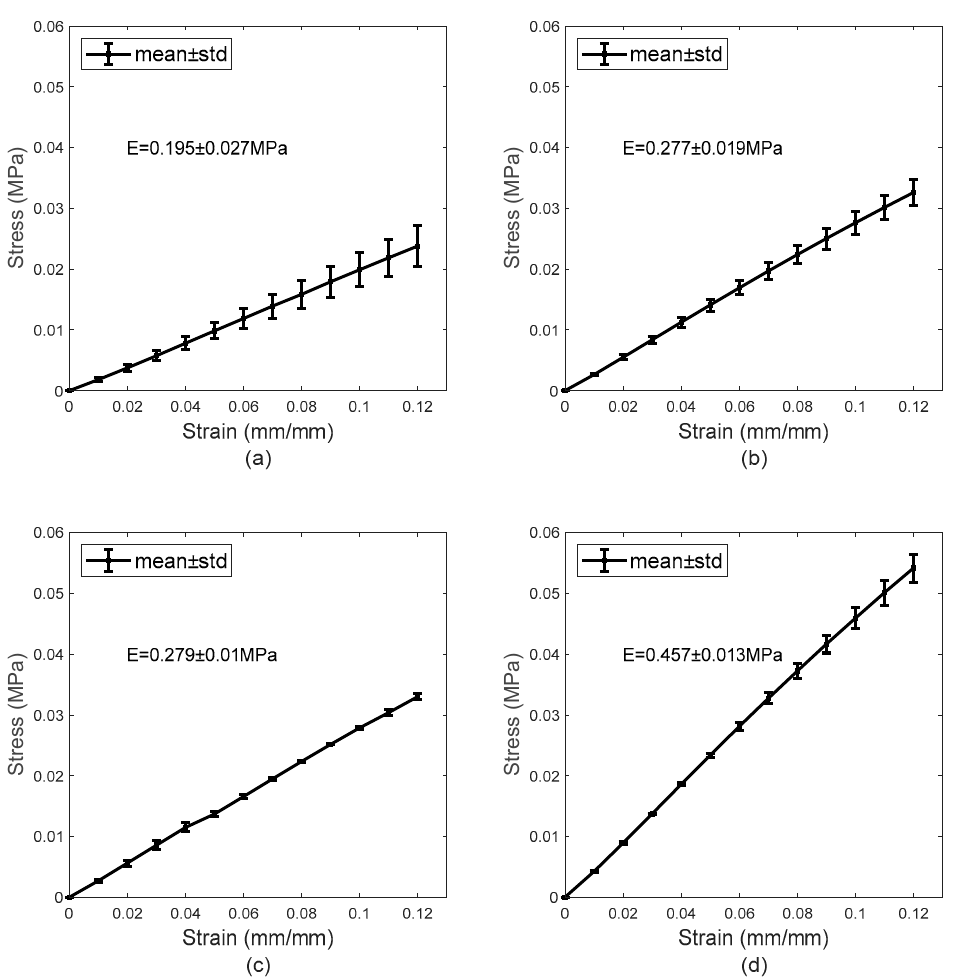
Figure 7. Mean stress–strain curves obtained during the tensile test for H77p0 ( a ), SiH74p5-blue ( b ), SiH74p5-clear ( c ), and H64p0 ( d ).